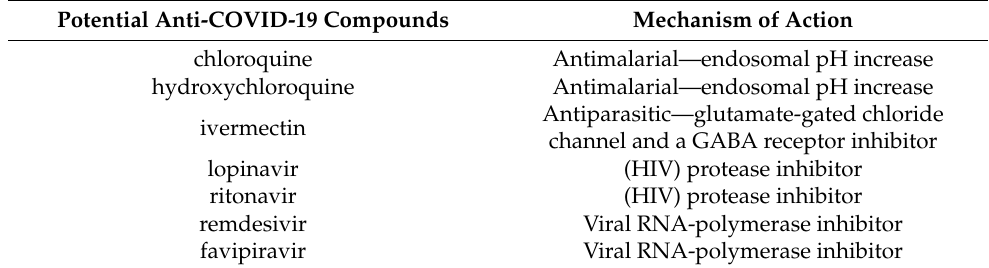
Table 1. Mechanism of action of the potential anti-COVID-19 drugs examined in this study. Potential Anti-COVID-19 Compounds Mechanism of Action chloroquine Antimalarial—endosomal pH increase hydroxychloroquine Antimalarial—endosomal pH increase Antiparasitic—glutamate-gated chloride ivermectin channel and a GABA receptor inhibitor lopinavir (HIV) protease inhibitor ritonavir (HIV) protease inhibitor remdesivir Viral RNA-polymerase inhibitor favipiravir Viral RNA-polymerase